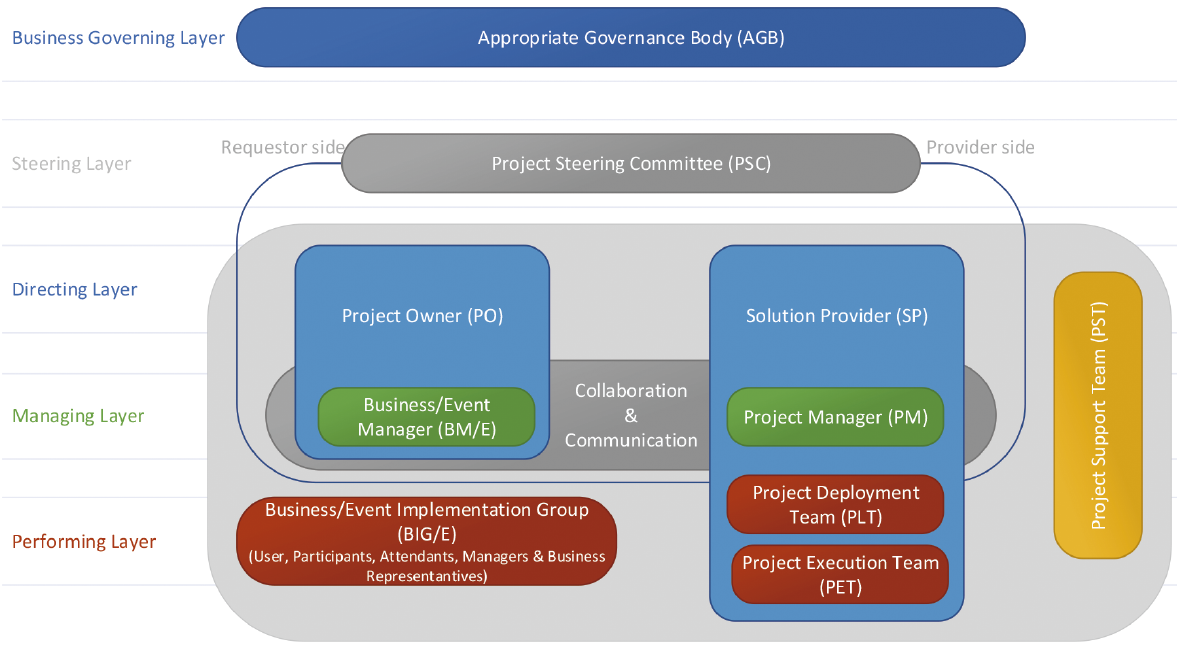
Figure 3. PM 2 governance model for sports